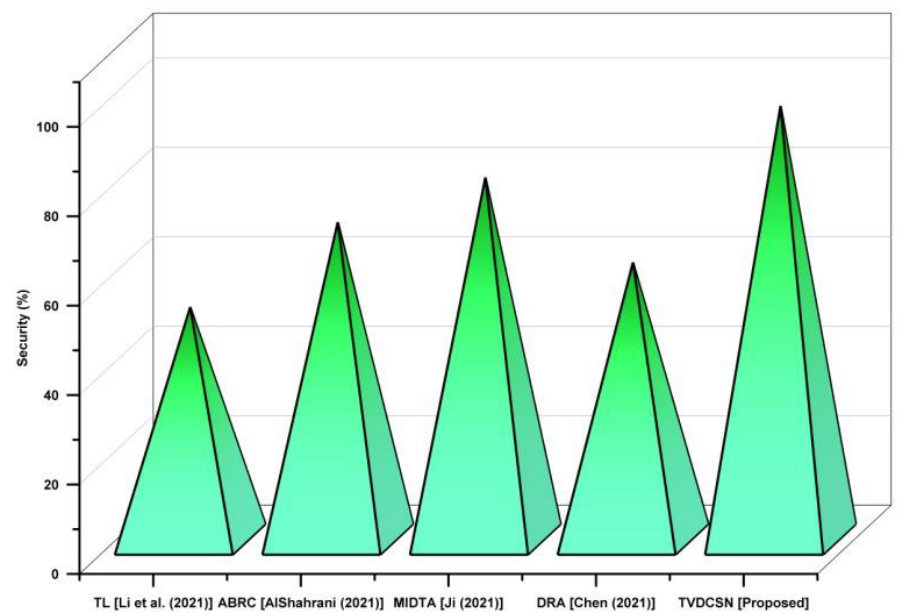
Figure 7. Proposed and existing methods of Figure 8. Proposed and existing methods of security. Table 3. Values of proposed and existing methods of security .